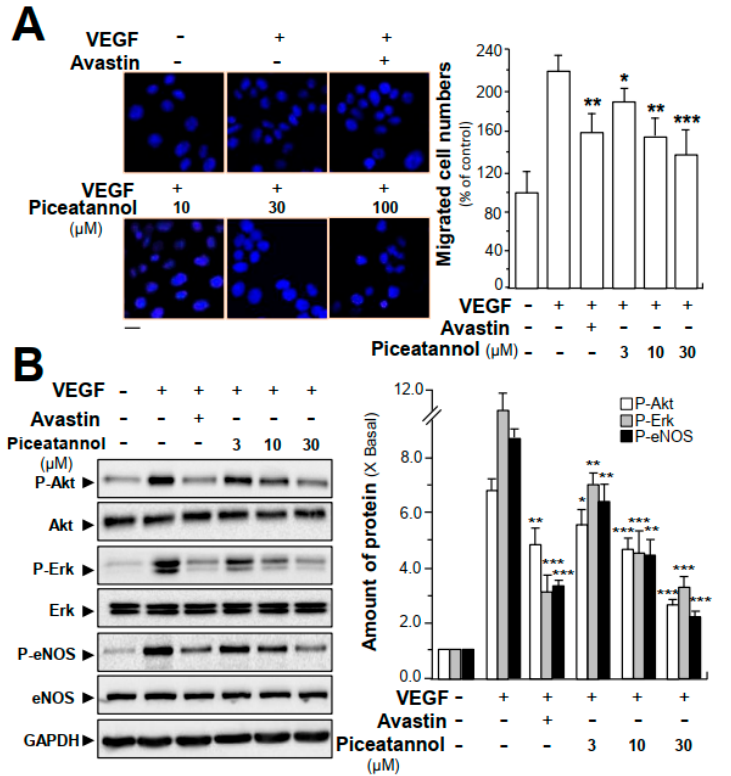
Figure 8. Piceatannol modulates VEGF-mediated function in colon cancer cells. ( A ) HT-29 colon cancer cells were treated with VEGF (10 ng/mL) with or without piceatannol or Avastin (200 µg/mL) for 24 h. Transwell ® motility assay was performed. The migrated cancer cells were counted. One of the representative images of the migrated cells is shown. The quantification data are demonstrated in right panel. Bar = 20 µm; ( B ) HT-29 colon cancer cells were treated with VEGF (10 ng/mL) in the presence or absence of piceatannol for 24 h. Total protein was collected and revealed by western blotting analysis by specific antibodies. GAPDH was used as an internal control. Quantitation (right panel) was done from the band intensity in western blotting (left panel). Avastin (200 µg/mL) served as a positive control. Data expressed as the percentage of control or the fold of change than control (X Basal), where the control group (no drug) was set as 1, mean ± SEM, where n = 3; p < 0.05 (*); p < 0.01 (**); p < 0.001 (***) vs. VEGF-treated group.